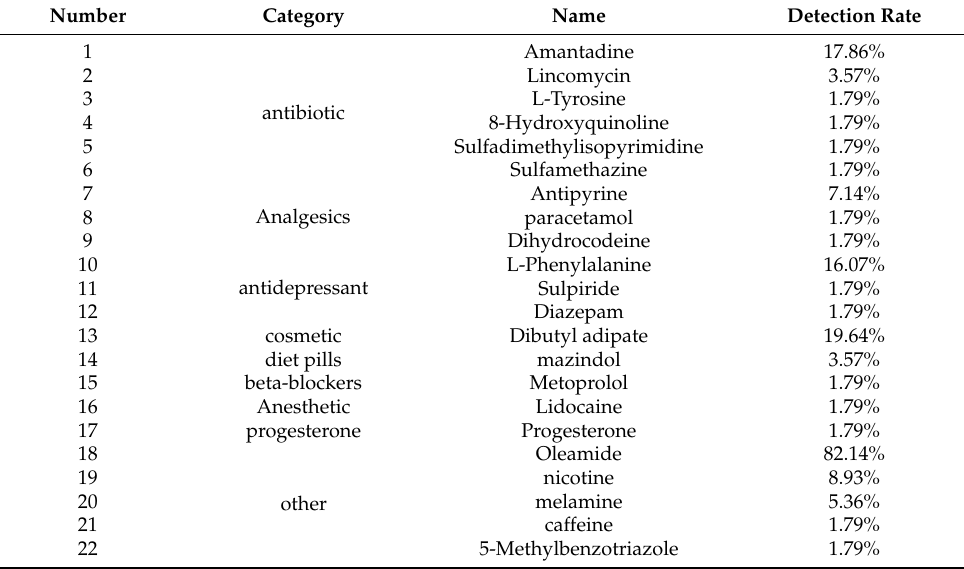
Table 2. PPCPs Detection